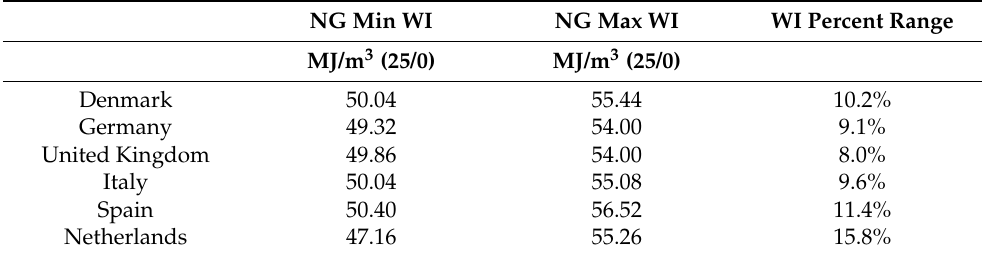
Table 5. WI (based on HHV) measured ranges by country [54].